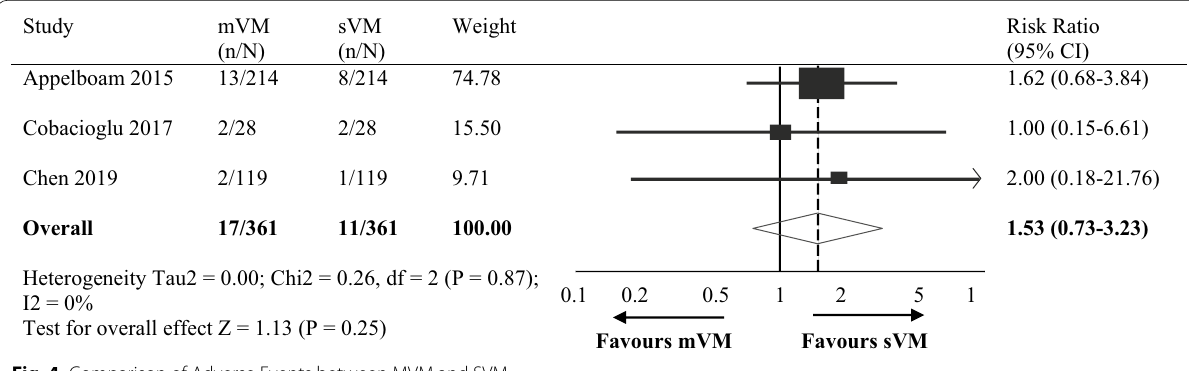
Fig. 4 Comparison of Adverse Events between MVM and